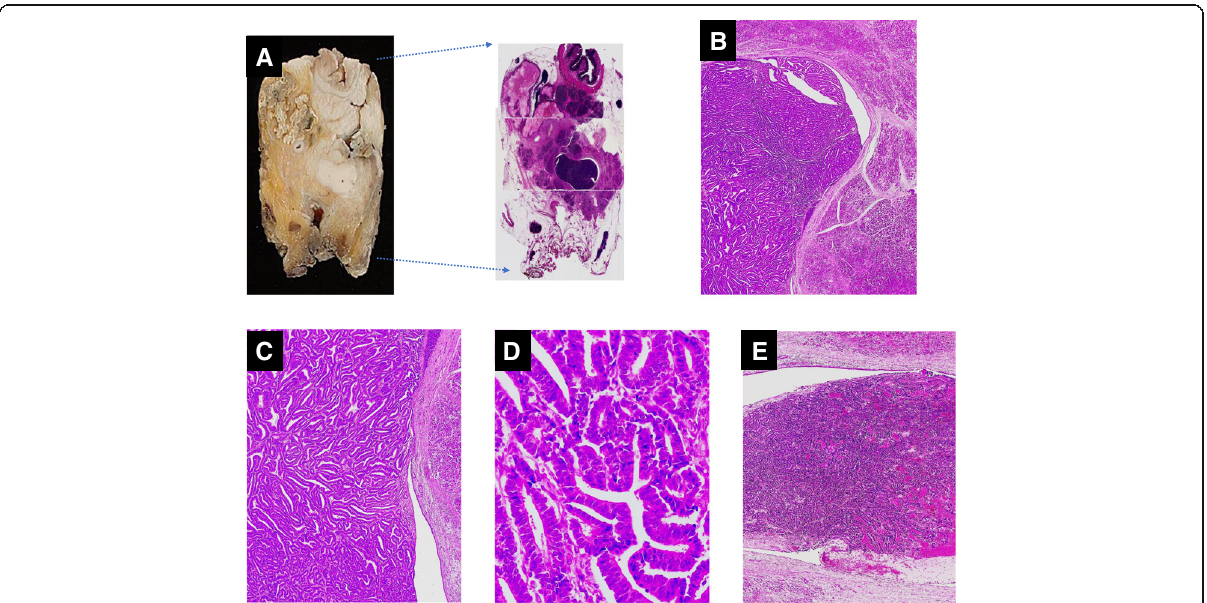
Fig. 2 Pathological findings of the initial resected specimen of the pancreas head lesion. a Macroscopic findings of the resected specimen. The tumor appeared as a solid nodule with a dilated main pancreatic duct. Secreted mucin was not visible. b – e Microscopic findings of the resected specimen. b Microscopic examination demonstrated that the tumor was confined to the pancreatic duct, and no apparent invasive carcinoma components were observed (original magnification, × 20). c Microscopic findings demonstrated a tubulopapillary growth pattern with scanty cytoplasmic mucin (original magnification, × 40). d The neoplastic cells showed a uniform high-grade atypia (original magnification, × 400). e Necrotic tissue within the tumor was observed (original magnification, ×